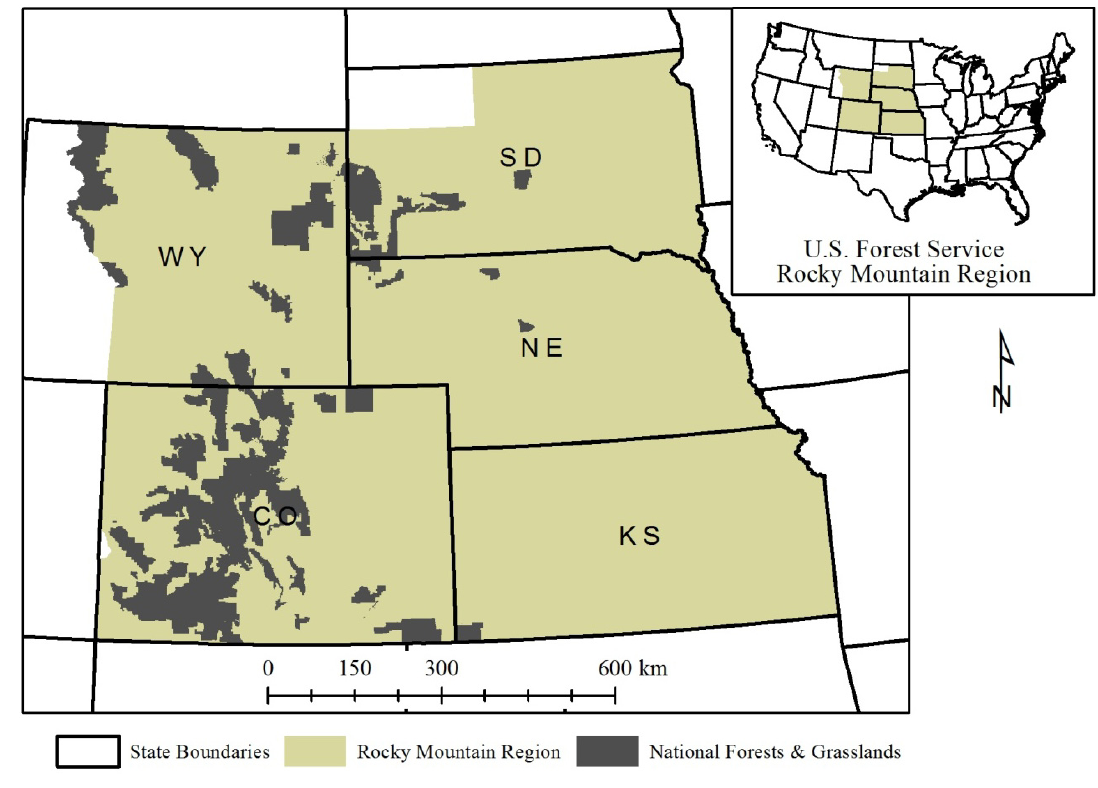
Figure 2. National Forests and Grasslands in the Forest Service’s Rocky Mountain